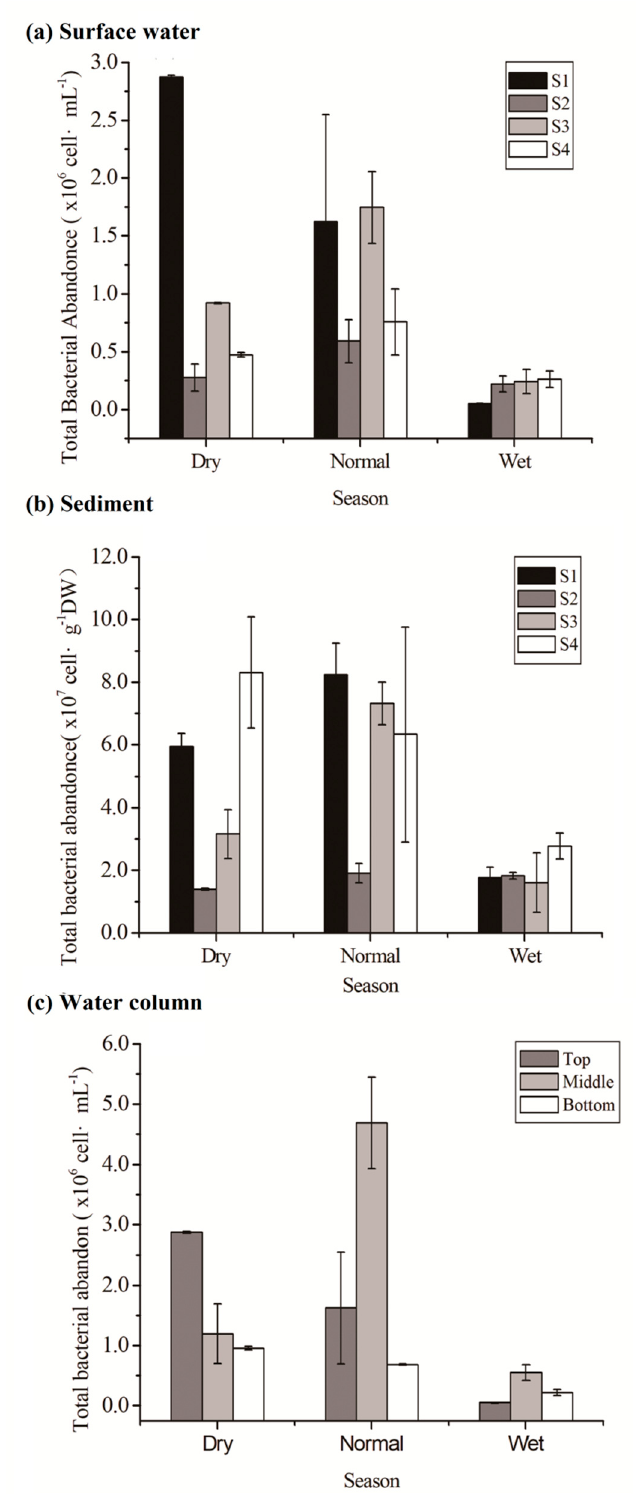
Figure 3. Total bacterial abundance in surface water ( a ), sediment ( b ), and water column (S1) ( c ) measured during different seasons. Error bars were calculated considering an average value derived from triplicate determinations carried out for each site. T: top; M: middle; B: bottom. When bacterial abundance in the reservoir was examined as a function of water depth, no depth dependency was found (Figure 3c): in normal and wet seasons , the highest value was obtained at the middle layer, whereas in the dry season, the highest value was observed at the top layer.